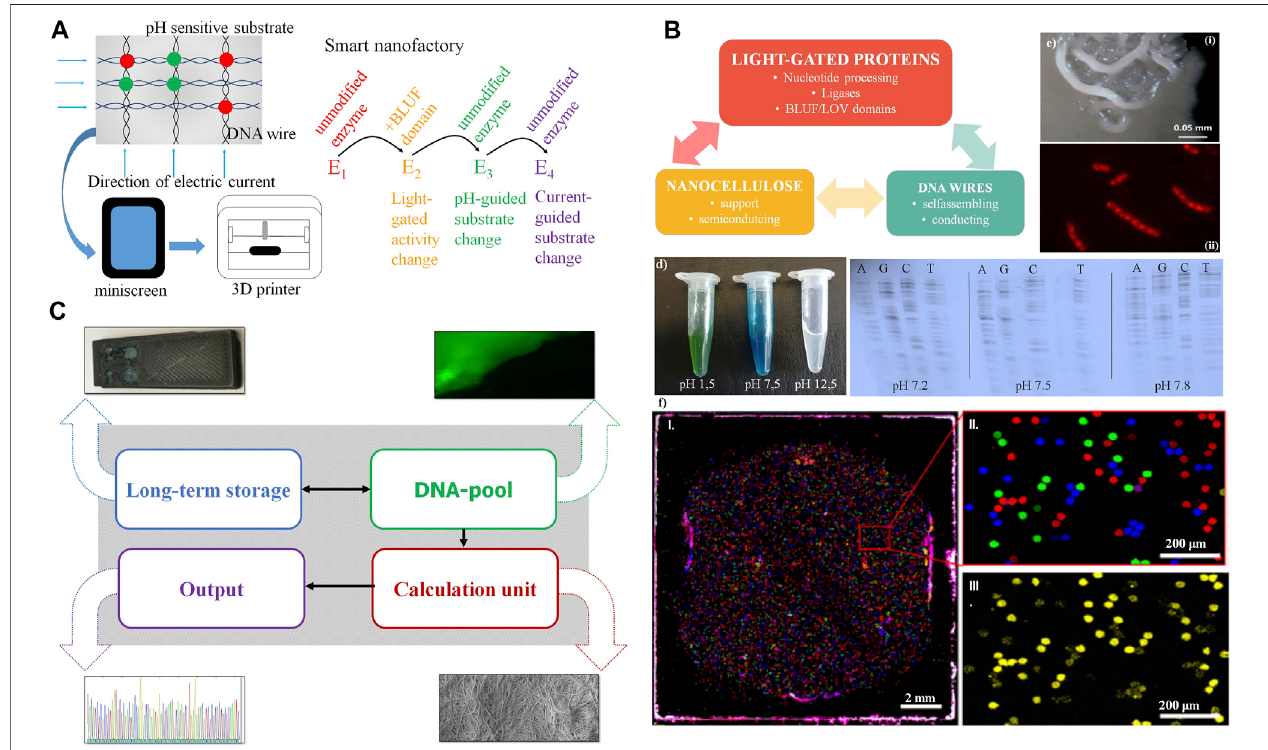
FIGURE 4 | Synergy from full integration of all components in the nanocellulose composite. (A) Further nanocellulose composite extensions: Output devices using the nanocellulose chassis as printer or mini screen; light-gated, current- or pH-guided enzymes have accurately controlled activity and substrate speci fi city by this and complement each other in nanocellulose composite cavities ( “ nanofactory ” ) or use the mini wells shown in (F) . (B) Smart card (or ultimately computer chip) combining nanocellulose, light-gated proteins and DNA wires. (C) Demonstrator: we integrate (i) DNA for storage (long-term storage); (ii) modify the DNA pool by fl uorescent nucleotides for read-in or read-out (DNA pool); (iii) do ef fi cient calculations combining DNA-processing enzymes, nanocellulose semiconductors, SETs (inset), and classical electronics integrated using the nanocellulose chassis (Jung et al., 2015) (calculation unit), and (iv) get ef fi cient sequence read-out (results) by fast sequencing (e.g.,next-generationsequencing,output). (D) Left:pH-sensitivedye(malachitegreen)onnanocellulose;right:polymerase(sequenase)speci fi cityaredifferentpHlevels. (E) Composite bio fi lmmodi fi cation: Top:patterningof B.subtilis bio fi lmintospatially de fi ned phenotypic changesbytheaccumulation ofspontaneous sinR mutationsin a subpopulation of Δ kinCD mutant; bottom: cells stained with Nile red. The dye accumulates in damaged regions ofthe membrane thus membrane-damaged areas are visualized asspotted Nile red areas in bacterial membranes. (F) PCR miniwells (Woehrle et al., 2020)with pico-cavitiesallow speci fi caccess toDNAstoragemolecules. (i) : normal size; (ii) : enlargement, different DNA molecule species (color); and (iii) : speci fi c read-out for one species